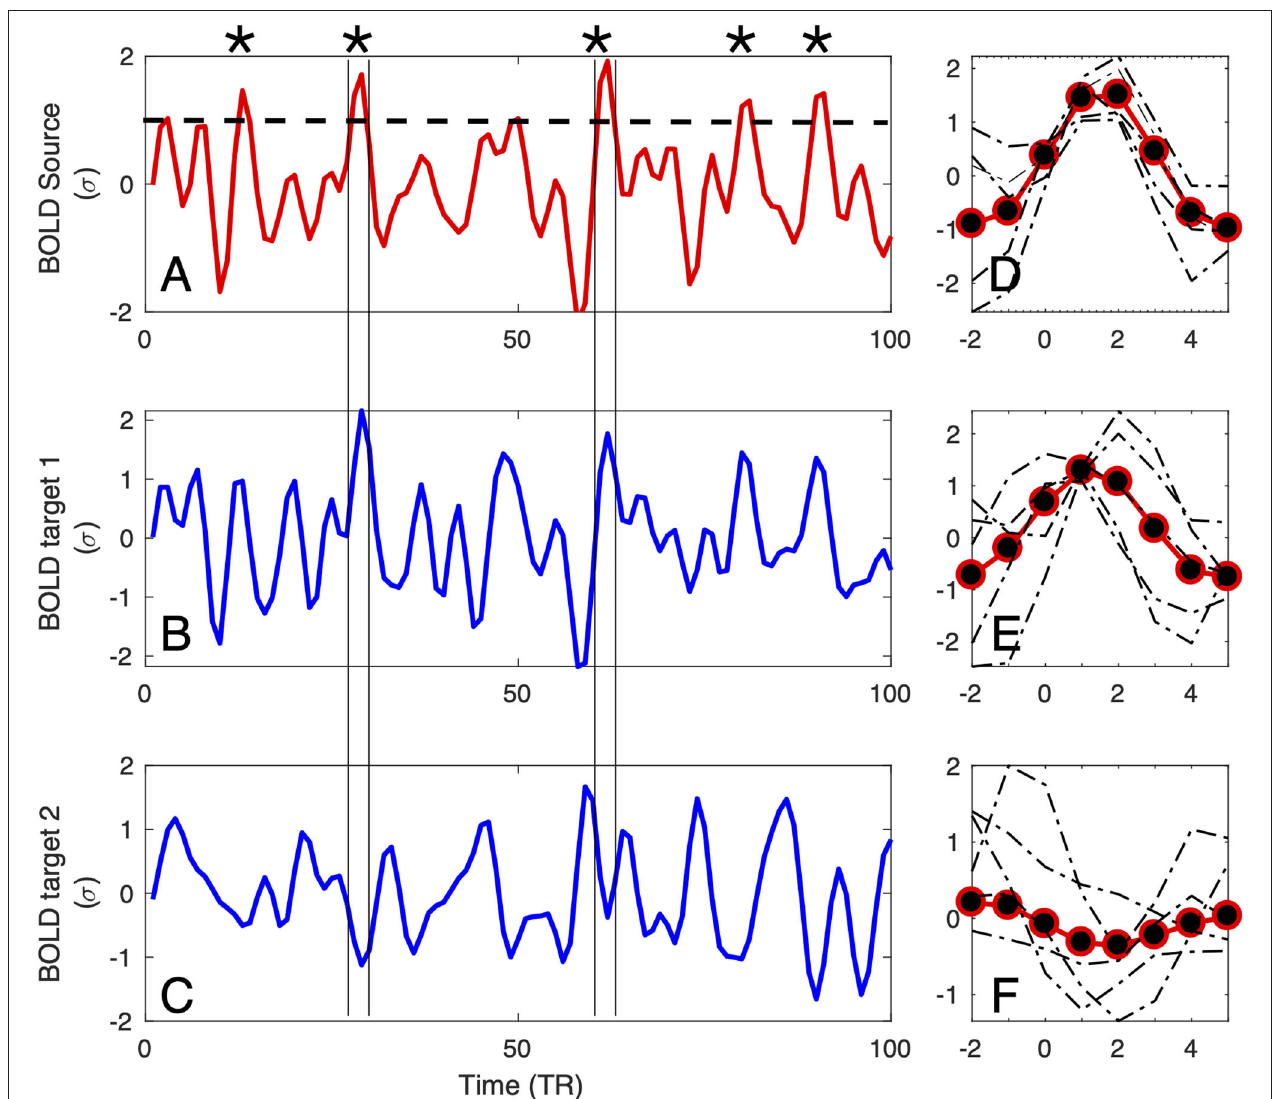
FIGURE 1 | Definition of the large amplitude BOLD events: For each source region (A) , BOLD-triggered events (asterisks) are defined at the times at which the BOLD signal crosses an arbitrary threshold [here set to 1 σ , denoted by the dashed line in (A) ]. For each detected source event, a target event is extracted (coinciding with the times of the source) from the BOLD signals of the other regions of interest (as the two examples in (B,C) denoted by vertical lines). Subsequently, the extracted events can be averaged (D–F) , and used for further computation of correlations, delays, and directionality.